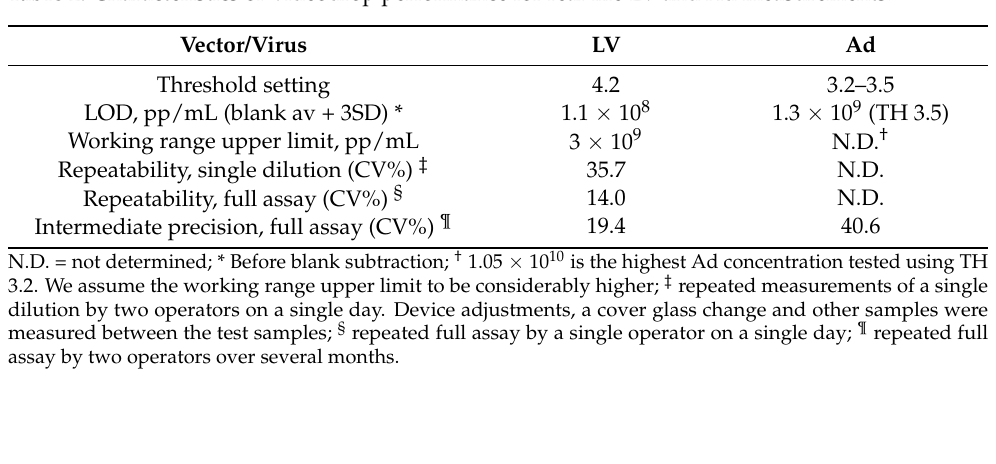
Table 2. Characteristics of Videodrop performance for real-life LV and Ad